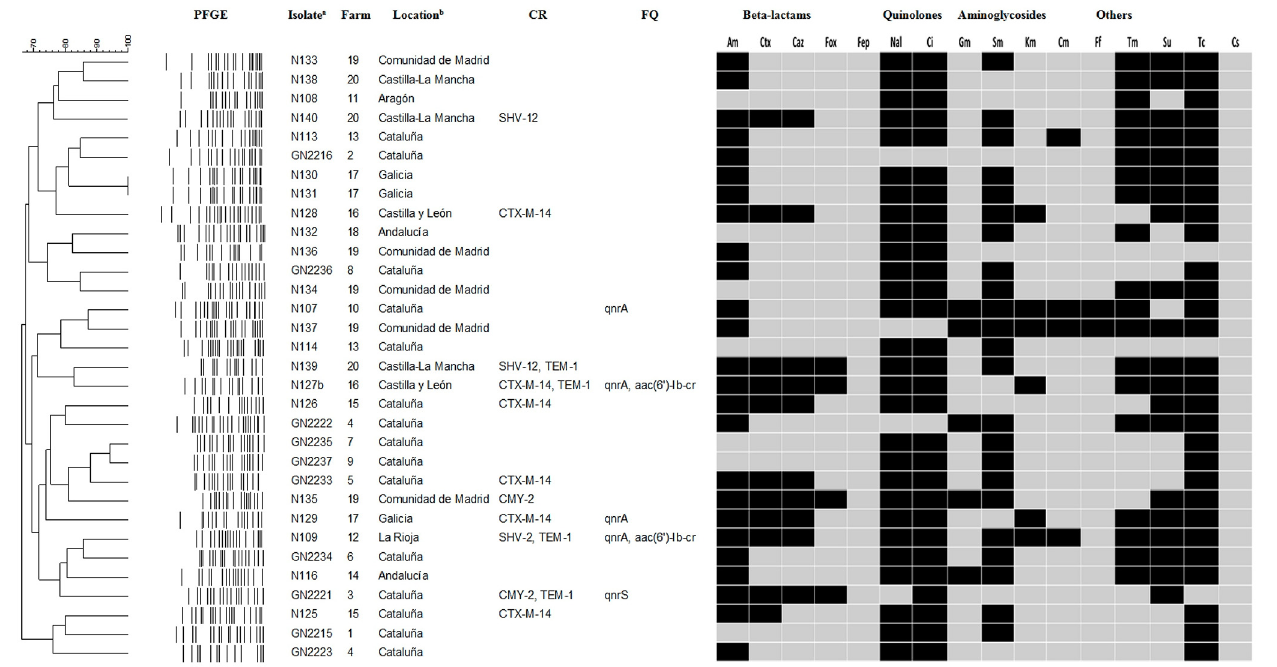
Fig 1. PFGE dendogram illustrating the phenotypic and genotypic relationship of the strains and the cephalosporin resistance genes. PFGE, pulsed-field gel electrophoresis; CR., cephalosporin resistance genes; FQ., flouoroquinolone resistance genes; Am: Ampicillin (WT (cid:1) 8mg/L); Ctx: Cefotaxime (WT (cid:1) 0.25mg/L); Caz: Ceftazidime (WT (cid:1) 0.5mg/L); Fox: Cefoxitin (WT (cid:1) 8mg/L); Fep: Cefepime (WT (cid:1) 0.125mg/L); Nal: Nalidixic acid (WT (cid:1) 16mg/L); Ci: Ciprofloxacin (WT (cid:1) 0.064mg/L); Gm: Gentamicin (WT (cid:1) 2mg/L); Sm: Streptomycin (WT (cid:1) 16mg/L); Km: Kanamycin (WT (cid:1) 8mg/L);. Cm: Chloramphenicol (WT (cid:1) 16mg/L); Ff: Florfenicol (WT (cid:1) 16mg/L); Tm: Trimethoprim (WT (cid:1) 2mg/L); Su: Sulphamethoxazole (WT (cid:1) 64mg/L); Tc: Tetracycline (WT (cid:1) 8mg/L); Cs: Colistin (WT (cid:1) 2mg/L). a Isolates are divided in APEC (N) and AFEC (GN) strains. b Location of the strains is named in order to the different regions of Spain where farms were